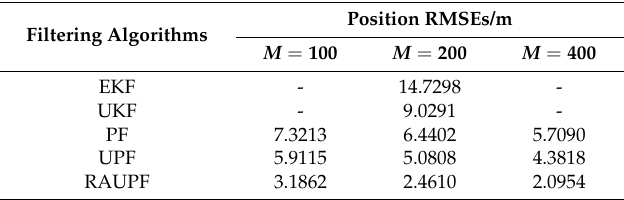
Table 5. The simulation results of the filtering